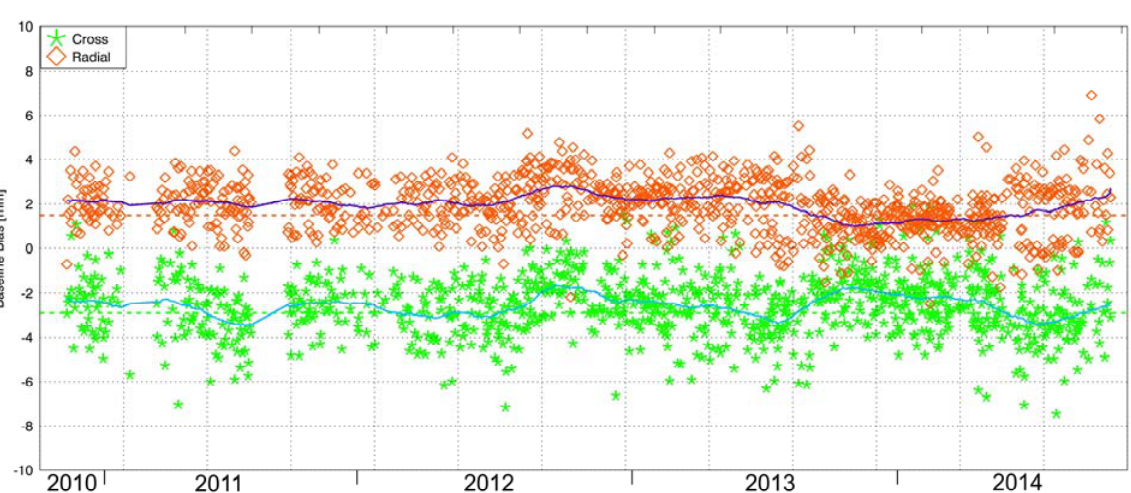
Figure 2. Long-term evolution of the estimated baseline bias: radial and cross-track components in red and green, respectively. The solid lines show the fitted mean values.